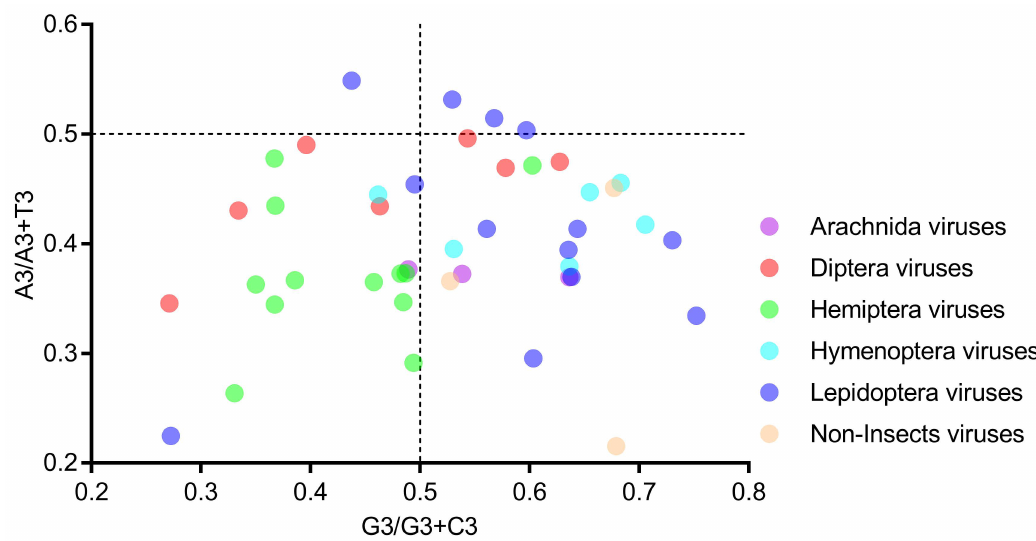
Figure 6. All viral genomes scattered away from the plot center of 0.5 in the PR2 bias analysis, suggesting that there exists a codon usage bias in iflavirus genomes. Members of the six host-taxa-groups were interspersed in the plot, implying that only an insignificant codon usage di ff erence existed across viral genomes. Each dot represents a genome corresponding to the two coordinate axes. The two dashed lines indicate no GC bias or no AT bias, respectively. The plot center (both coordinates are 0.5) indicates a position without a base